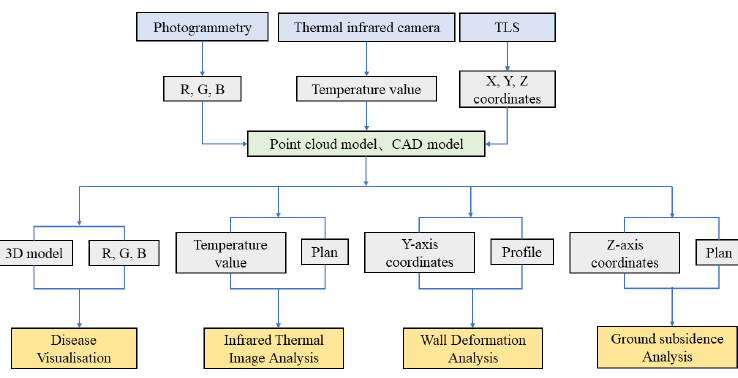
Figure 3. Pipeline of the proposed method.